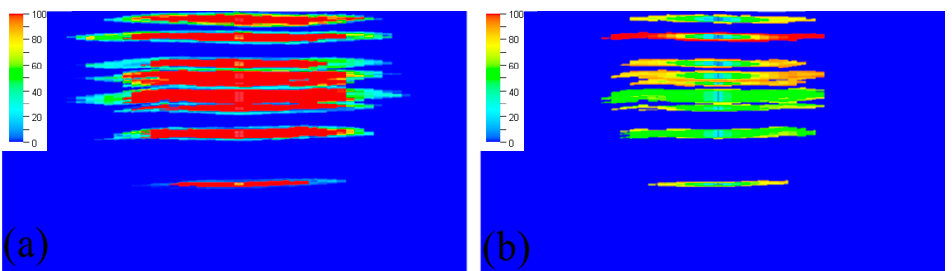
Figure 27. Horizontal permeability changes over time. ( a ) After fracturing; ( b ) after two years of production.